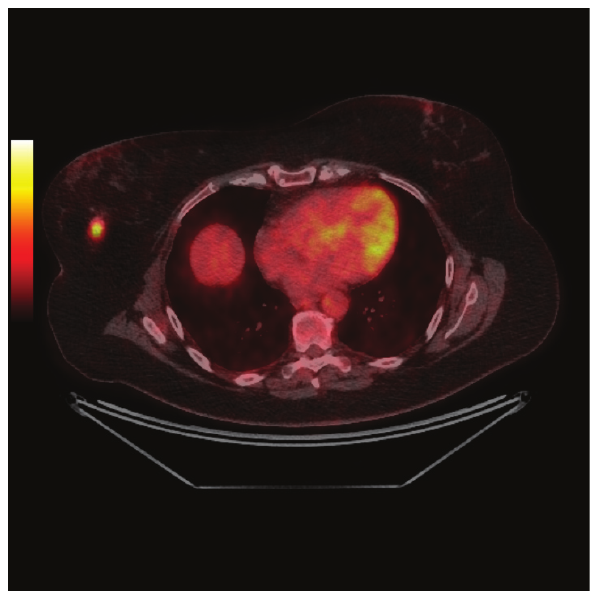
Figure 2A. FDG PET/CT image of the breast metastasis. Fused FDG PET/CT images showing an intense focal FDG uptake in the right breast coinciding with a dense breast nodule on CT images. The hot iron FDG PET scale represents intensity of FDG uptake, varying from black at the weakest intensity to white at the strongest.